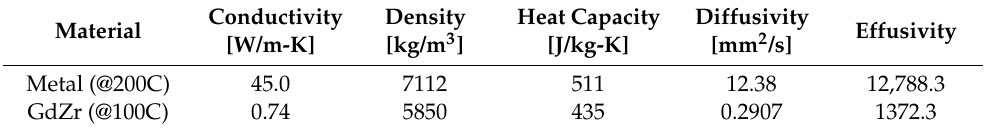
Table 4. Material properties for FEA